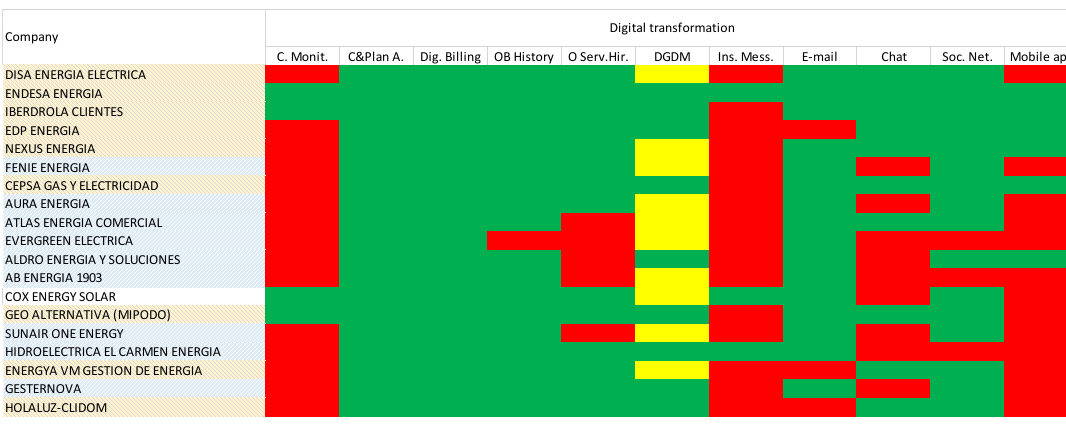
Figure A3. Summary of indicators of digital transformation. Indicator coloring scheme: green = 1; red = 0; yellow = 0.5. Company color scheme: yellow: Cluster 1; blue: Cluster 2; white: mixed results.